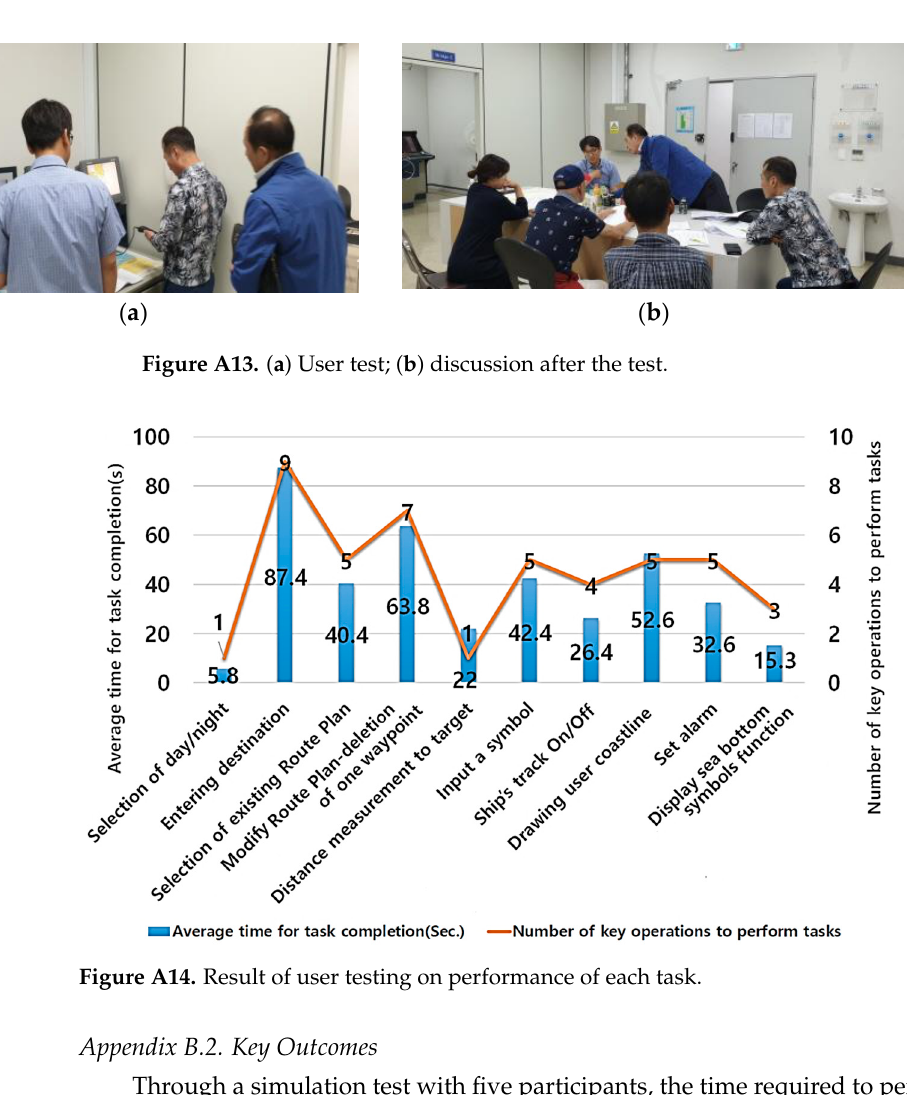
Figure A12. ( a ) Ship-handling simulator; ( b ) a chart table equipped with GPS plotter.